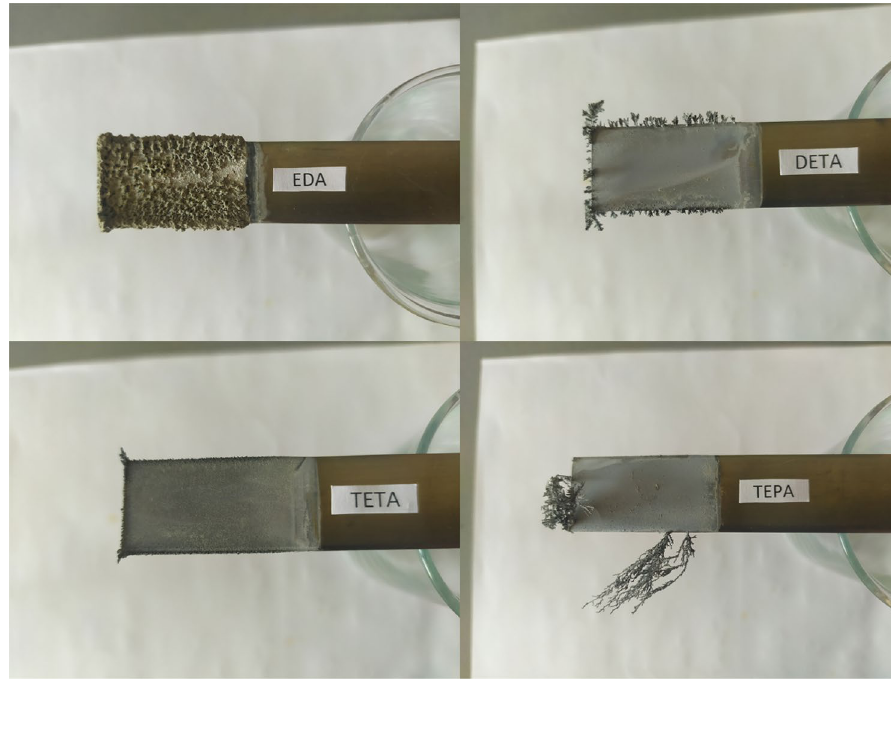
Fig. 2 XRD patterns of lead electrodeposited from differ- ent polyamine solutions (Pb signals marked in